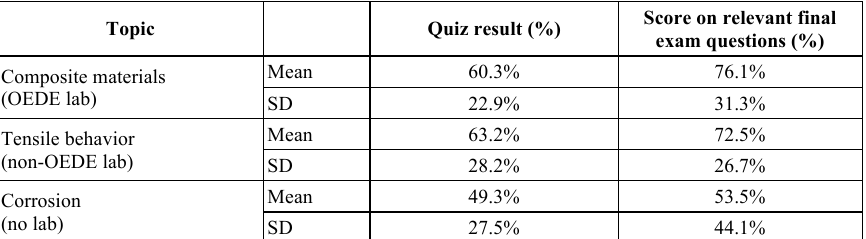
Table 1. Summary of scores (percentage of points earned) on assessments completed before (quiz) and after (final exam) a laboratory exercise